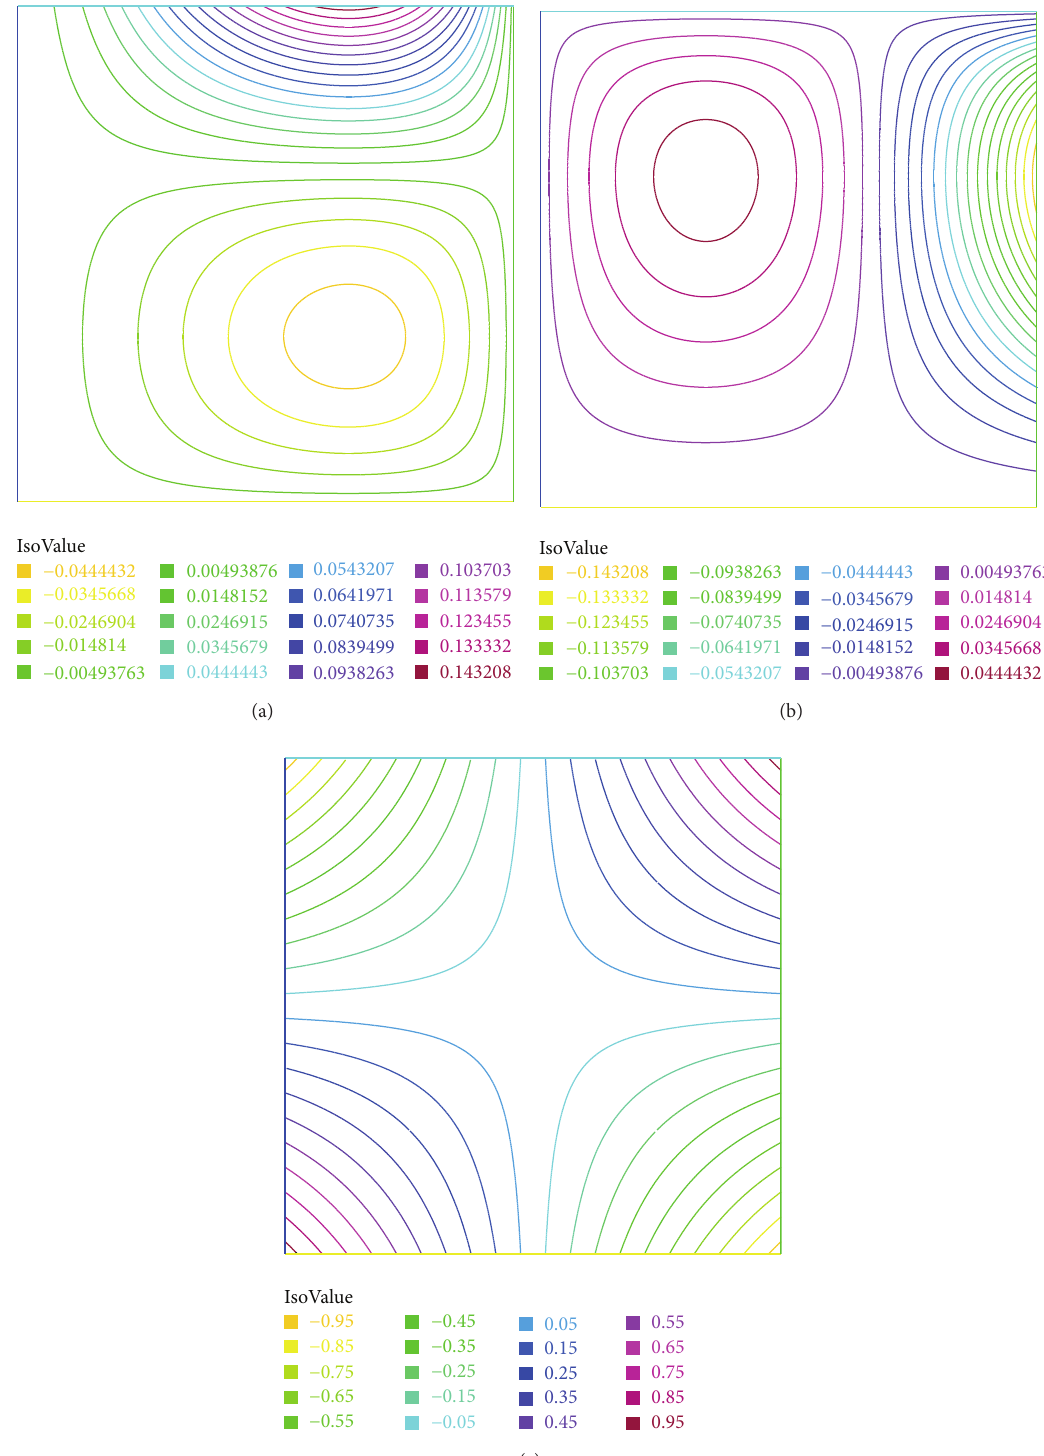
Figure 2: Contour plots of exact solution. From (a) to (c): two components of velocity and